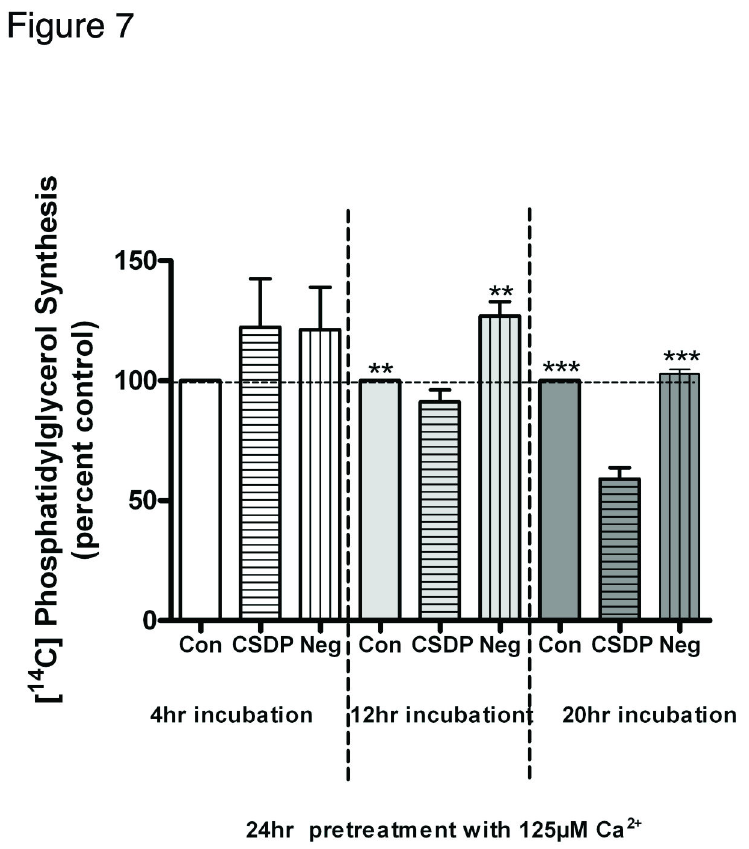
Figure 7. The caveolin-1 scaffolding domain peptide decreases phosphatidylglycerol levels in calcium-pretreated keratinocytes. Keratinocytes were pretreated for 24 hours with SFKM containing 125 µM calcium prior to treatment for the indicated times with vehicle (DMSO) or 3µM caveolin-1 scaffolding domain peptide (CSDP) or the negative control (Neg) as indicated. [ 14 C]Phosphatidylglycerol levels were then measured as described in the Materials and Methods. Values are expressed as the percent vehicle and represent the means ± SEM of 3 separate experiments performed in duplicate; **p<0.01 versus the control or CSDP; †††p<0.001 versus the control or negative